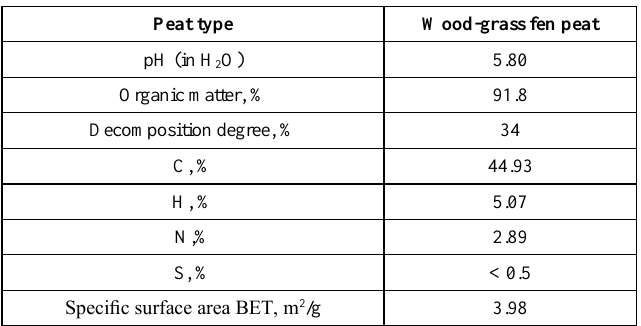
TABLE III C HEMICAL C HARACTERISTICS OF A NALYSED W OOD -G RASS F EN P EAT S